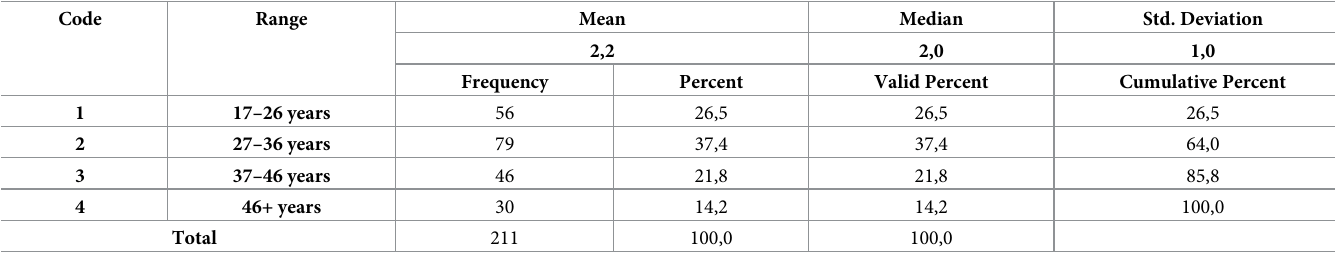
Table 4. Age distribution of